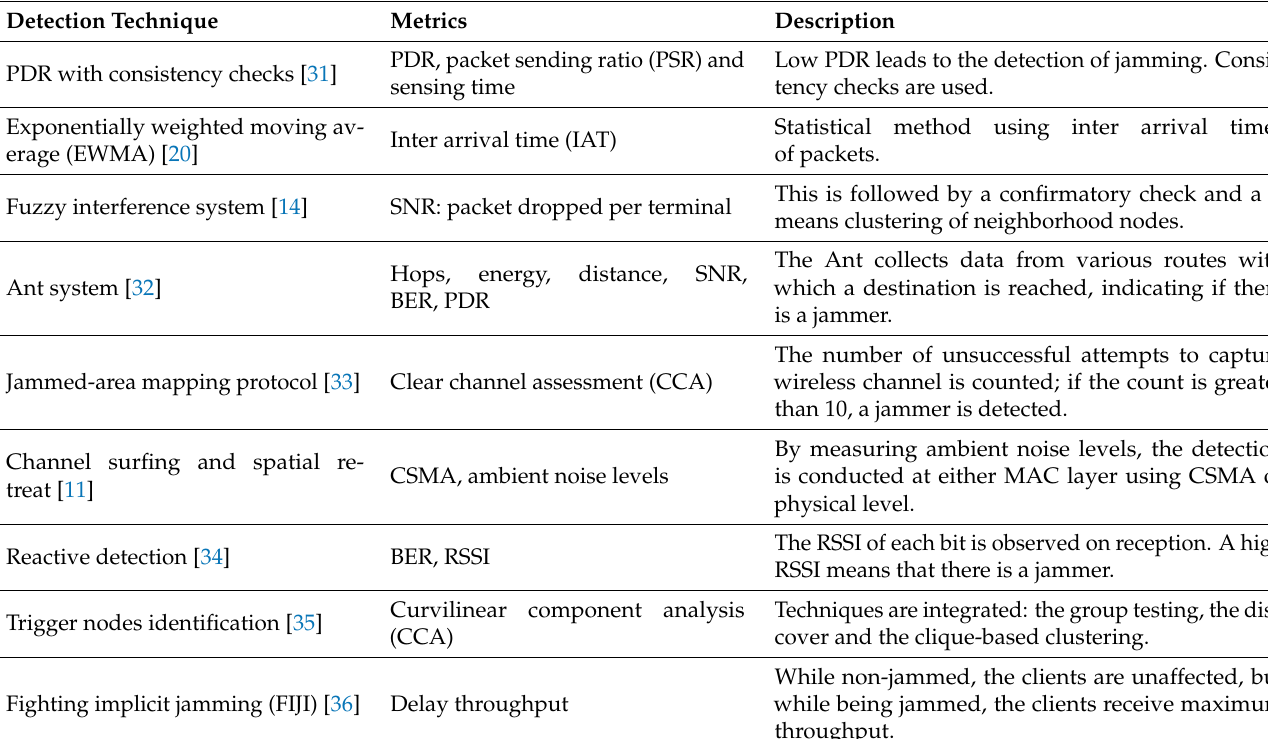
Table 2. Overview of detection